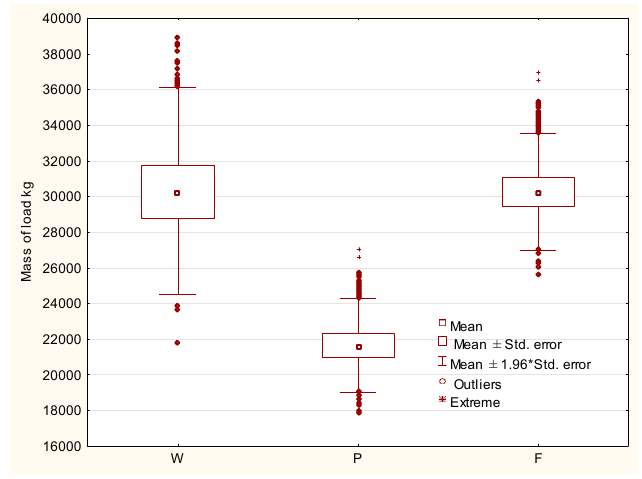
Figure 7. Comparison of real load mass with calculated. (W)- Real mass of the weighing load, (P)- Calculated mass of load by the conversion factor 740 kg · m − 3 , (F) - Calculated load mass based on a specific function.